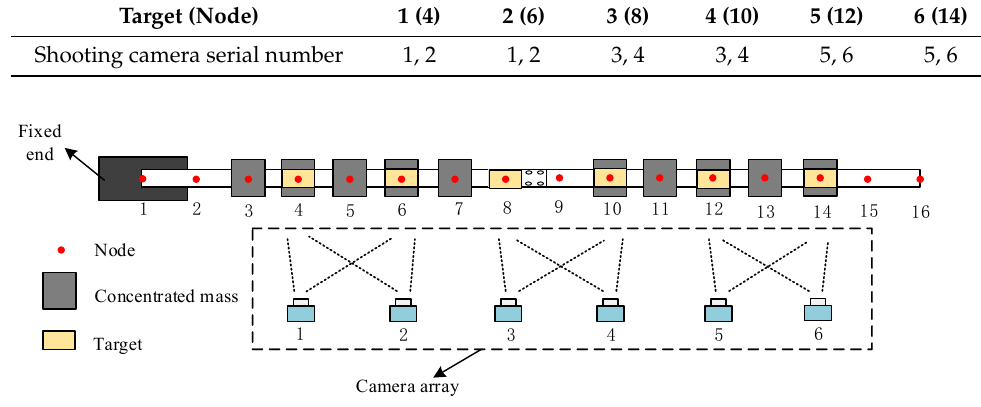
Figure 11. Schematic diagram of test layout.